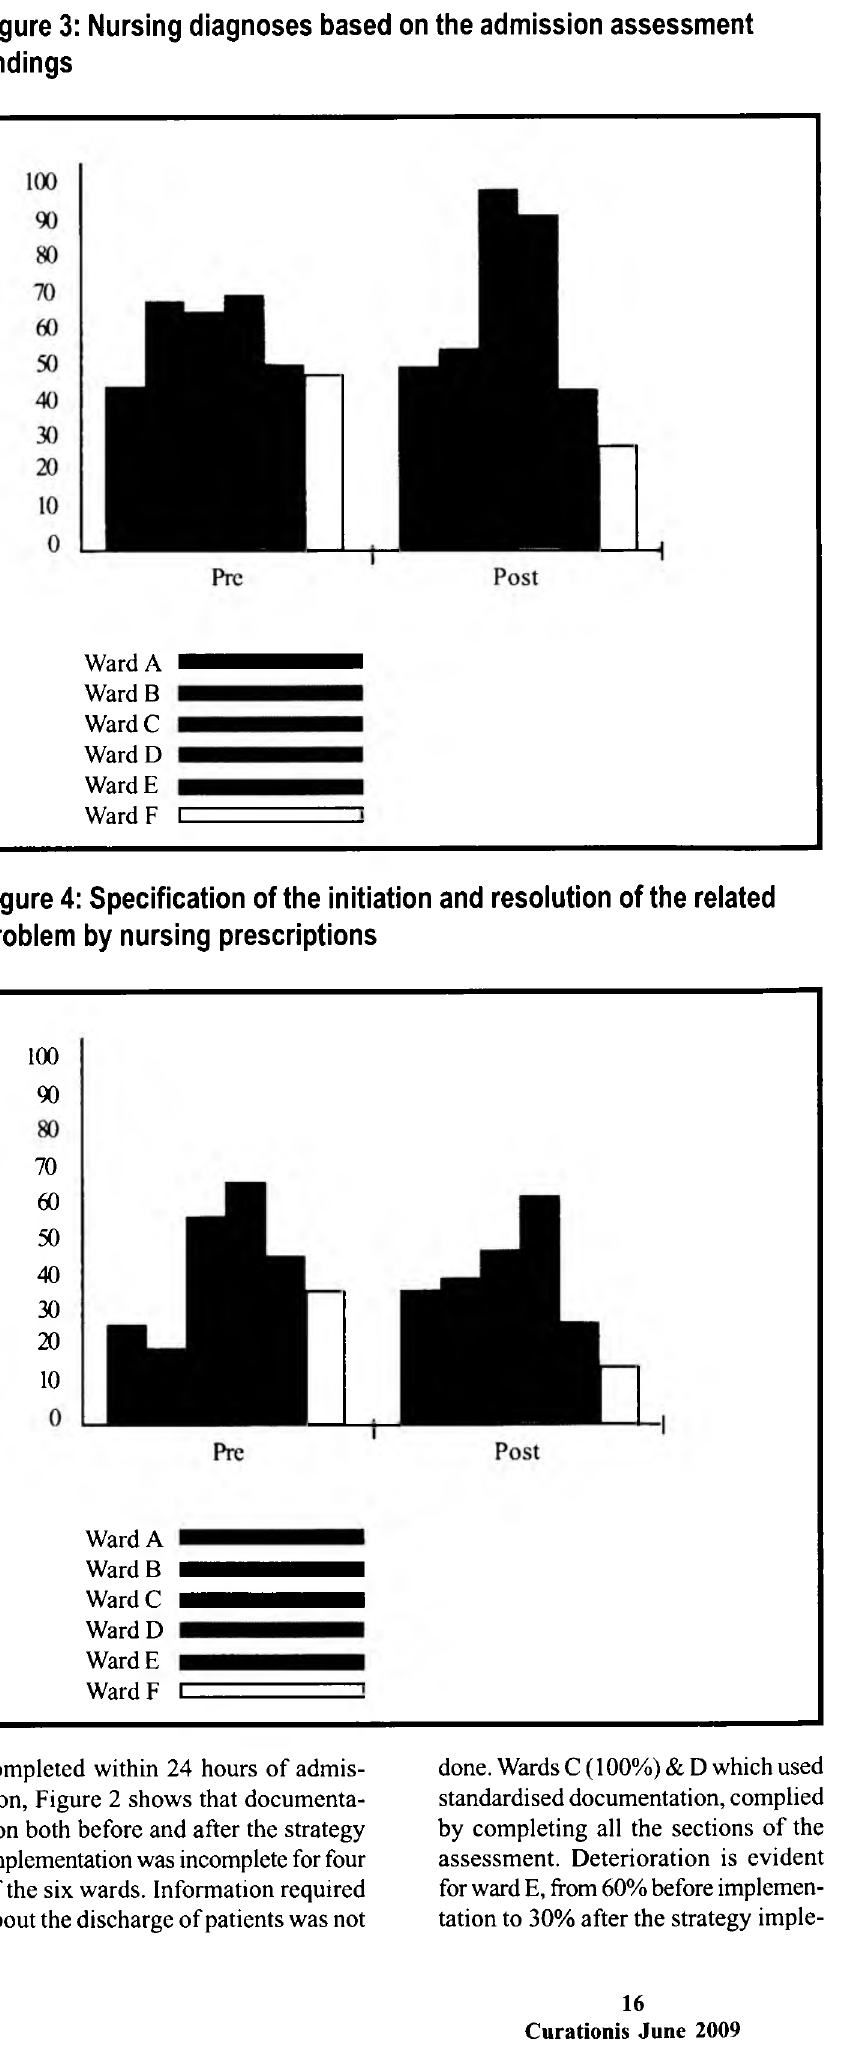
Figure 3: Nursing diagnoses based on the admission assessment findings mentation.